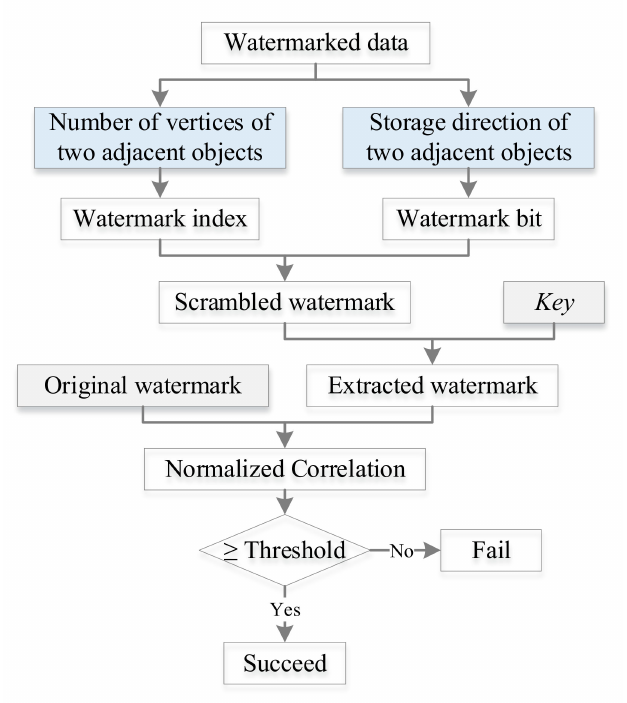
Figure 5. Watermark extraction